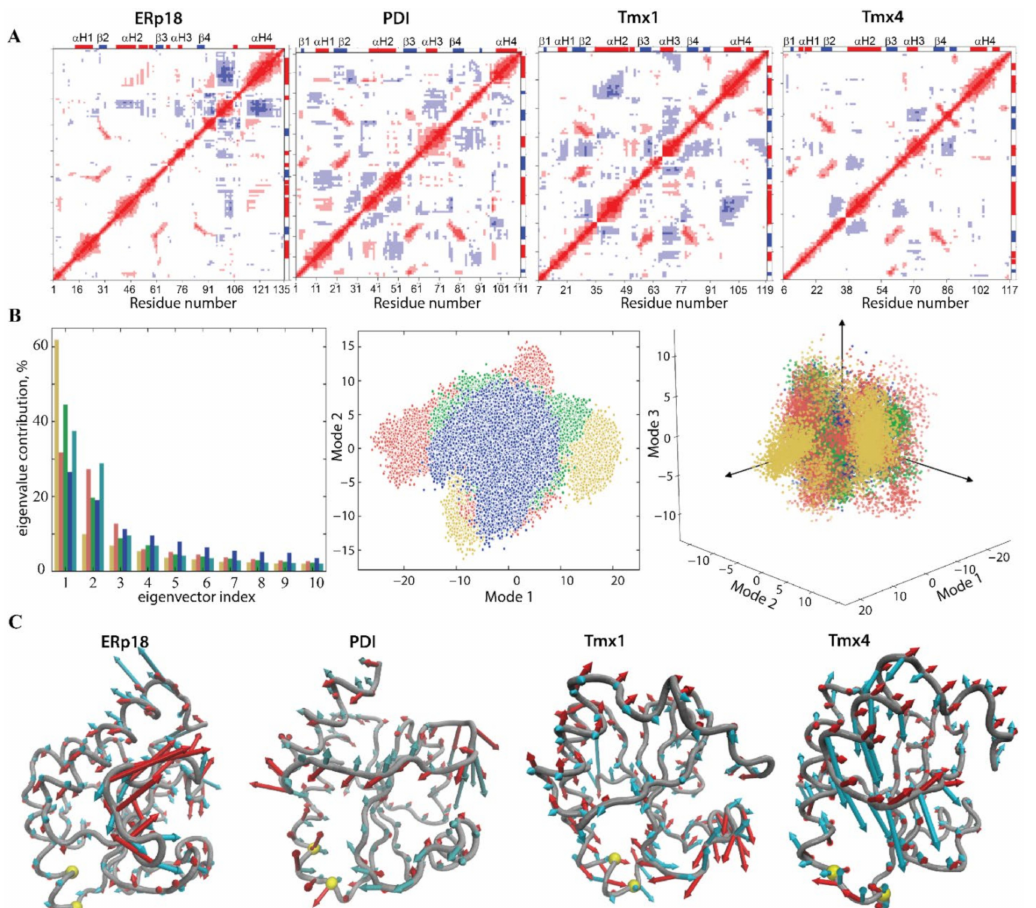
Figure 3. Intrinsic motion in the Trx-folded proteins and its interdependence. ( A ) Inter-residue cross-correlation maps computed for the C α -atom pairs of ERp18, PDI, Tmx1 and Tmx4 after the fitting procedure. Secondary structure projected onto the protein sequences ( α -helix/ β -strand in red/blue) is shown at the border of matrices. Correlated (positive) and anticorrelated (negative) motions between C α -atom pairs are shown as a red–blue gradient. ( B ) The PCA modes calculated for each protein after least-square fitting of the MD conformations to the average conformation as a reference. The bar chart gives the eigenvalue spectra in descending order for the first 10 modes (left). Projection of ERp18, PDI, Tmx1 and Tmx4 MD conformations with the principal component (PC) in 2D (middle) and 3D subspaces (right). MD conformations were taken every 100 ps (2D) and 10 ps (3D). The protein data is referenced by colour—ERp18 (dark yellow), PDI (brown), Tmx1 (green) and Tmx4 (dark blue and light blue for two replicas). ( C ) Collective motions characterised by the first two PCA modes. Atomic components in PCA modes 1–2 are drawn as red (1st mode) and cyan (2nd mode) arrows projected on a tube representation of each protein. For clarity, only motion with an amplitude ≥ 2 Å is represented. Cysteine residues are shown as yellow balls. All computations were performed on the C α -atoms with RMSF fluctuations less than 4 Å for each protein after fitting on the initial